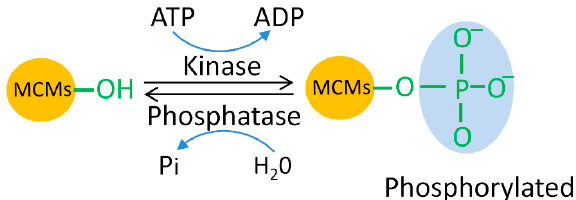
Figure 1. Mini-chromosome maintenance (MCM) phosphorylation. ADP, adenosine diphosphate; ATP, adenosine triphosphate.